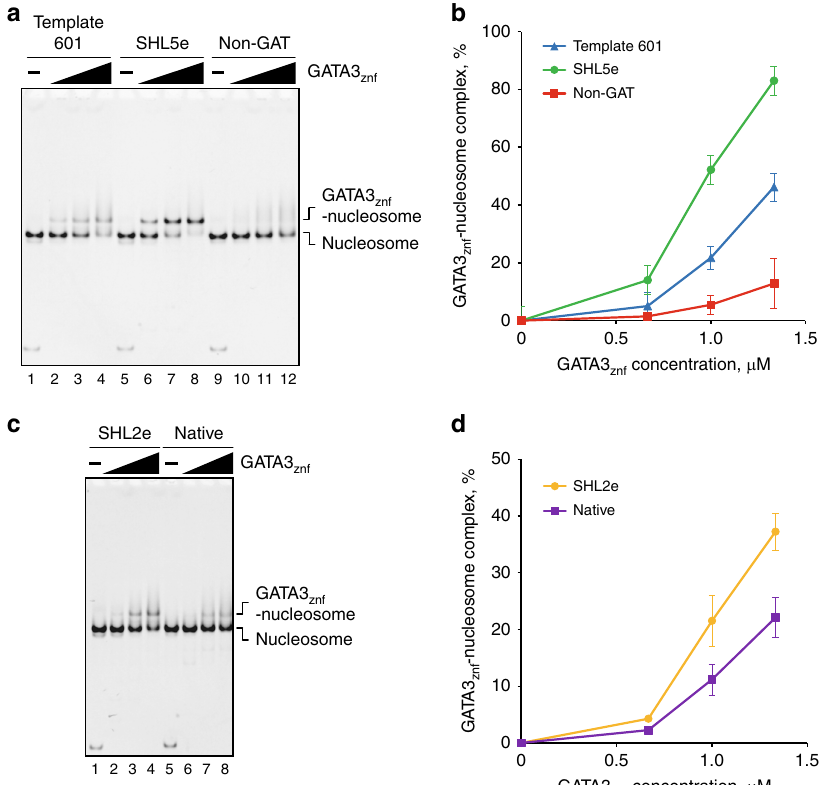
Fig. 3 GATA3 znf speci fi cally recognizes nucleosomal target DNA. a EMSA of the GATA3 target or non-target nucleosomes with GATA3 znf . The nucleosome (0.33 μ M) was mixed with GATA3 znf (0, 0.67, 1.0, and 1.33 μ M). The reaction mixtures were incubated at 25°C for 30min and were then analyzed by native-PAGE. The gel was stained with ethidium bromide. Lanes 1 – 4, 5 – 8, and 9 – 12 indicate results for the nucleosomes containing template Widom 601, SHL5e, and non-GAT, respectively. Three independent experiments were performed and the reproducibility was con fi rmed (Supplementary Fig. 4a, b). b Quanti fi cation of the results shown in a . The average % values of three independent experiments shown in a and Supplementary Fig. 4a, b were plotted against the GATA3 znf concentration. Data are represented as mean values±SD ( n = 3 independent biological replicates). Source data are provided as a Source Data fi le. c EMSA of a nucleosome containing a native human genome sequence containing the GATA3 target sites. The nucleosome (0.33 μ M) was mixed with GATA3 znf (0, 0.67, 1.0, and 1.33 μ M). The reaction mixtures were incubated at 25°C for 30min and were then analyzed by native-PAGE. The gel was stained with ethidium bromide. Lanes 1 – 4 and 5 – 8 indicate results for the nucleosomes containing SHL2e and native sequence with GATA sites around SHL2, respectively. Three independent experiments were performed and the reproducibility was con fi rmed (Supplementary Fig. 4c, d). d Quanti fi cation of the results shown in c . The average % values of three independent experiments shown in c and Supplementary Fig. 4c, d were plotted against the GATA3 znf concentration. Data are represented as mean values±SD ( n = 3 independent biological replicates). Source data are provided as a Source Data fi